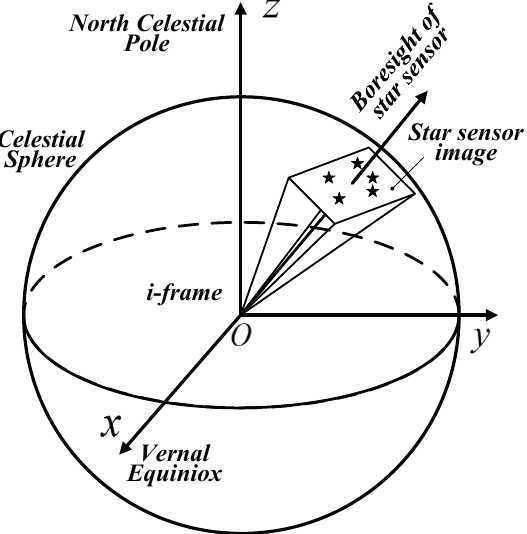
Figure 2. The principal of the star